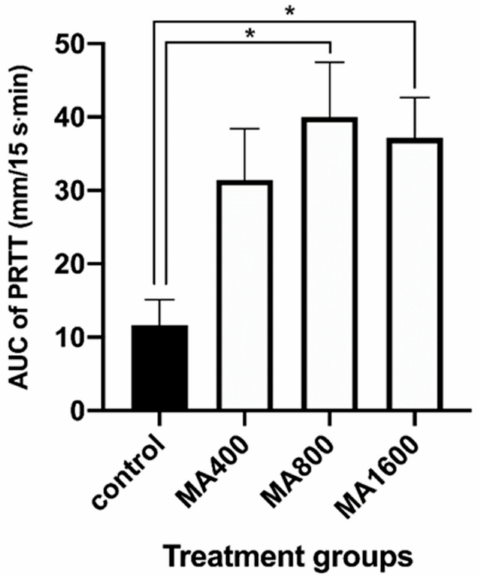
Figure 2. The mean ± standard deviation of the area under the curve (AUC) of phenol red thread test (PRTT) values from 25 to 60 min after medetomidine administration ( n = 8). (*) Statistical di ff erences with significance ( p < 0.01) compared with the control